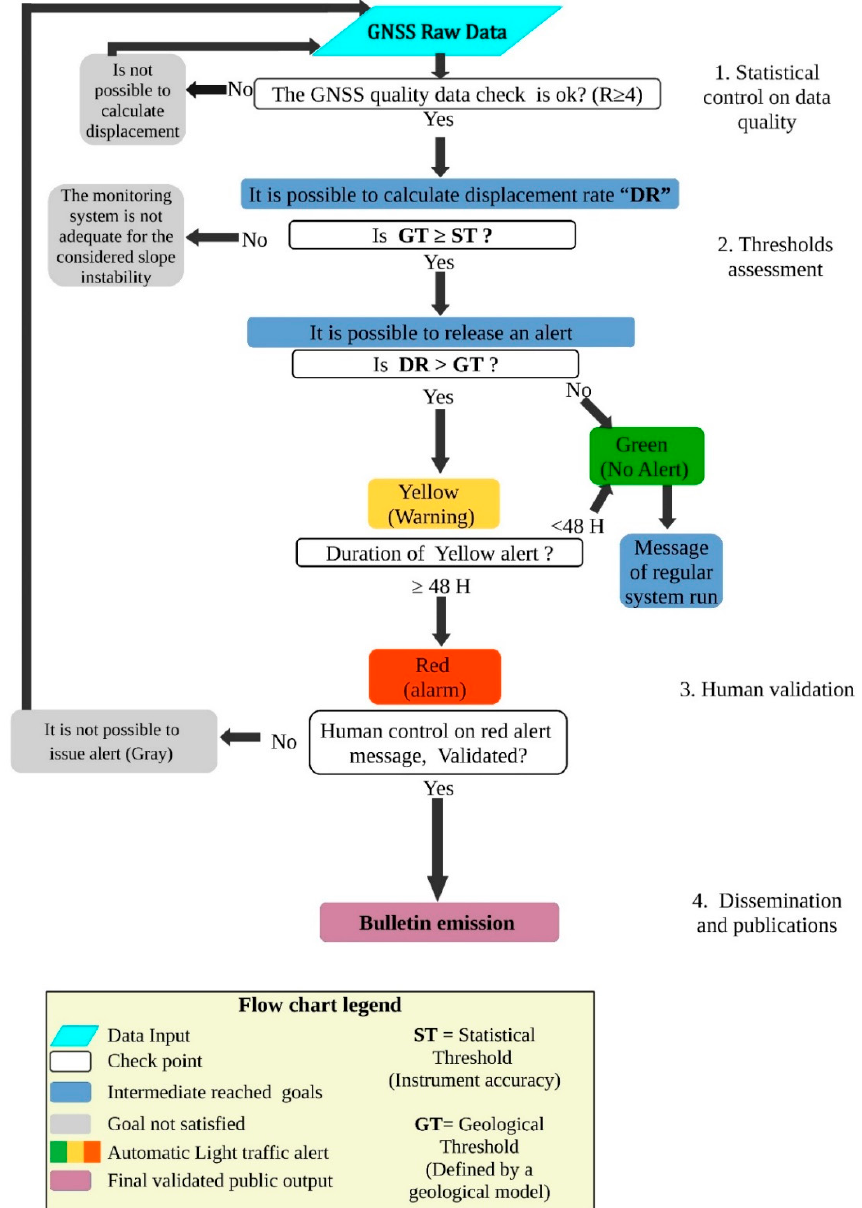
Figure 7. Flowchart of the proposed procedure to define and test the alert threshold based on continuous and low-cost GNSS monitoring. The chart is focused on daily processing, but the same schema could be applied to long-term thresholds.